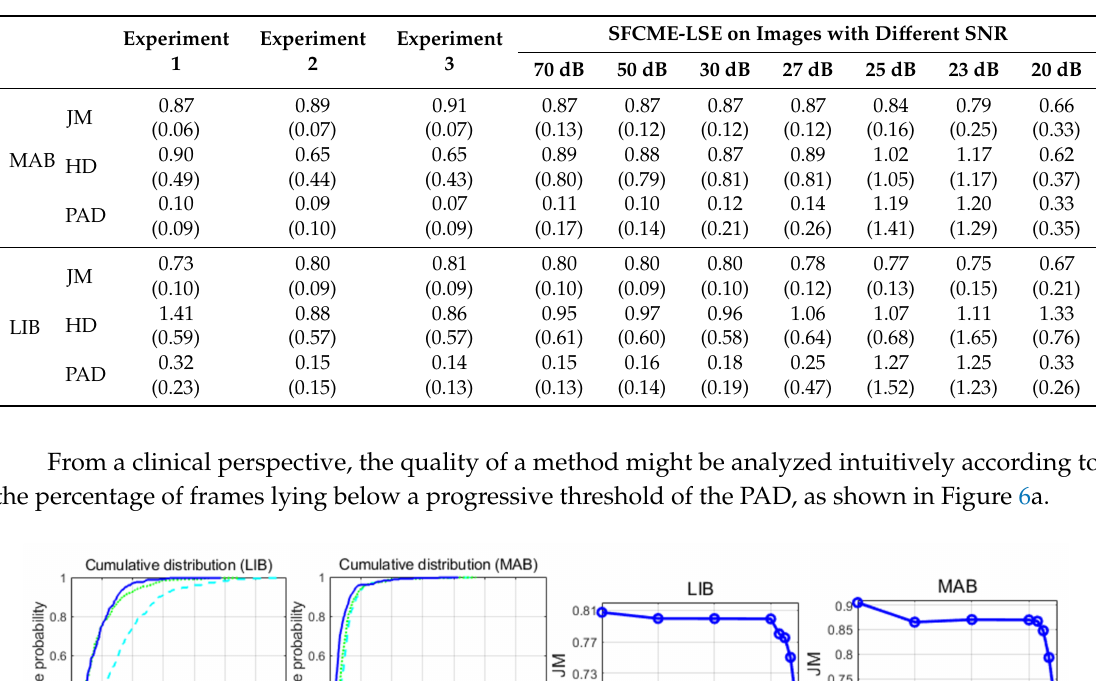
Table 3. The performance of the proposed method on Dataset I. The format is mean (standard deviation).